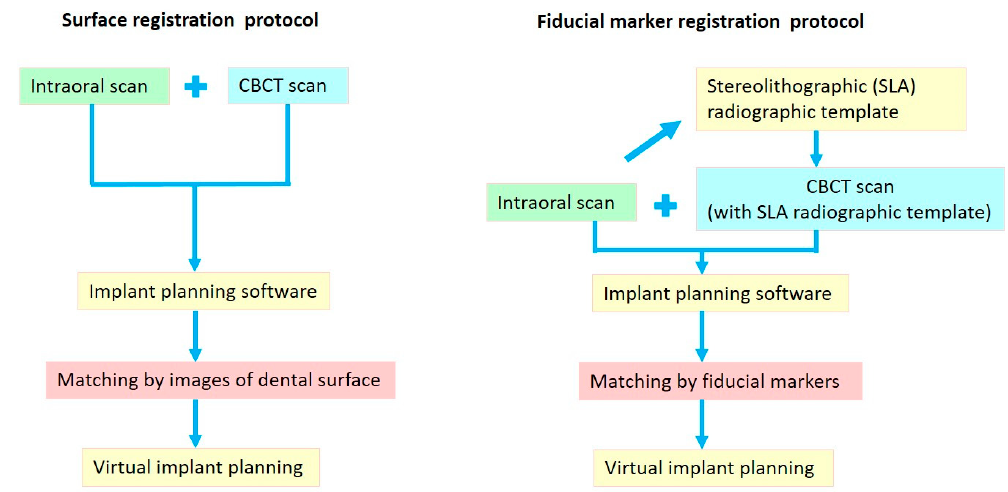
Figure 3. Workflow of digital implant planning.